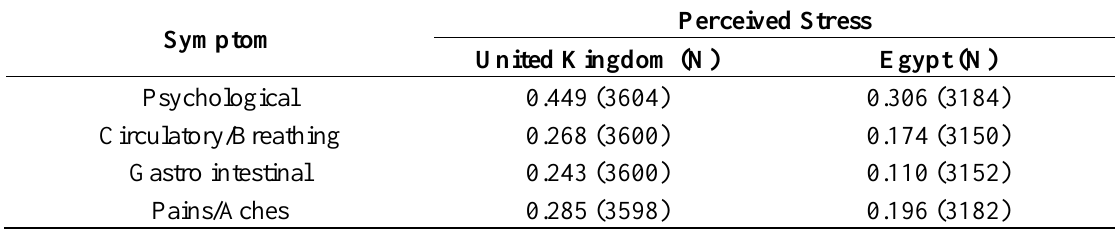
Table 6. Correlations between symptoms and perceived stress among UK and Egyptian university